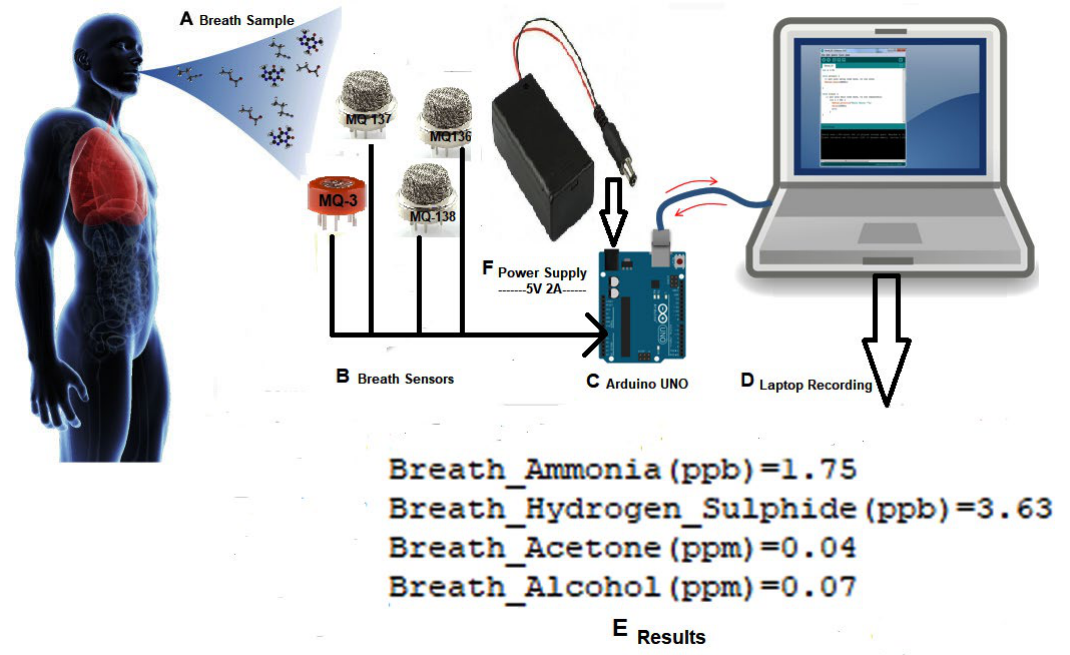
Figure 2. Diagram of Device Design and Interfacing.